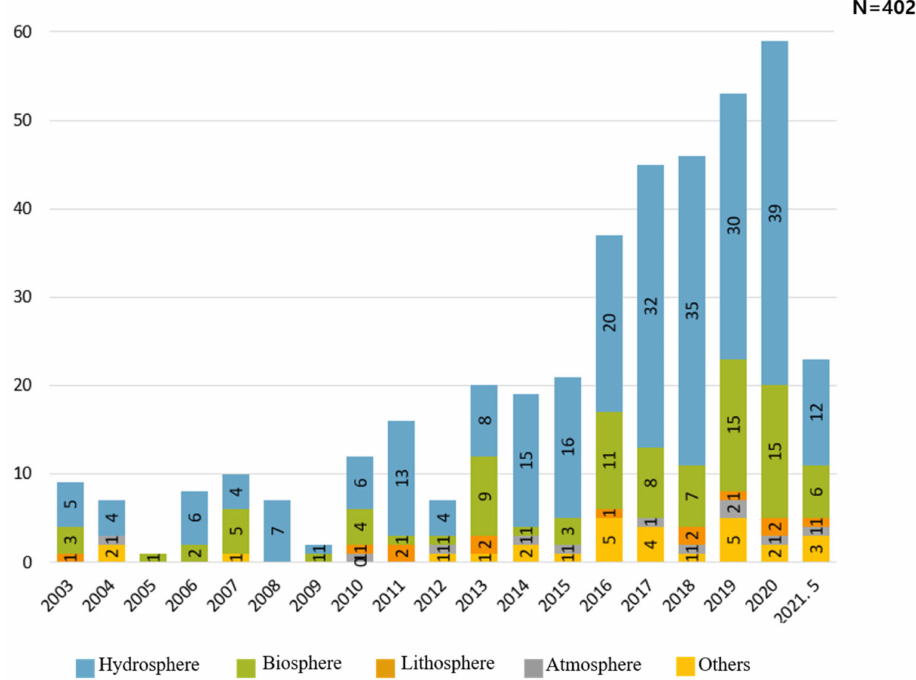
Figure 3. Number of articles on natural resource conflicts by the Earth spheres and published